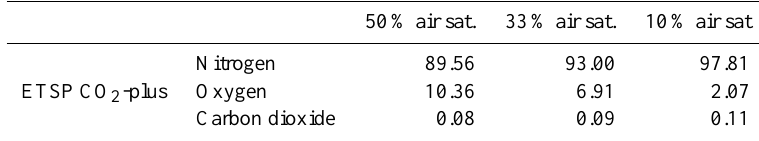
Table 2. Recommended volumetric composition for premixed gases for the ETSP OMZ.